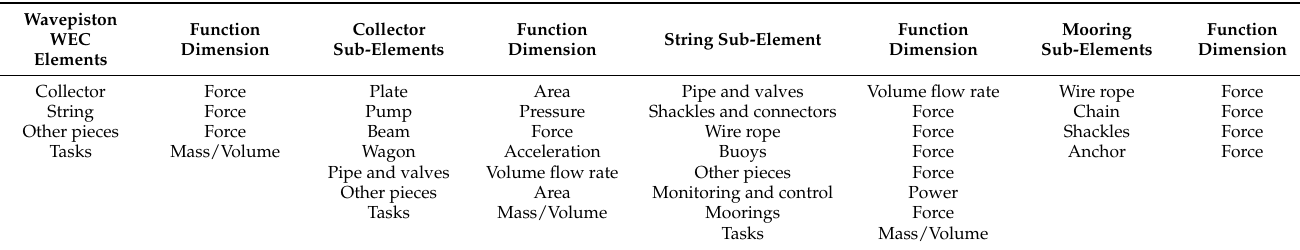
Table 6. Functionality-related dimension of Wavepiston WEC elements and sub-elements (organised as in Figure 4) following de Andres et al. [50].